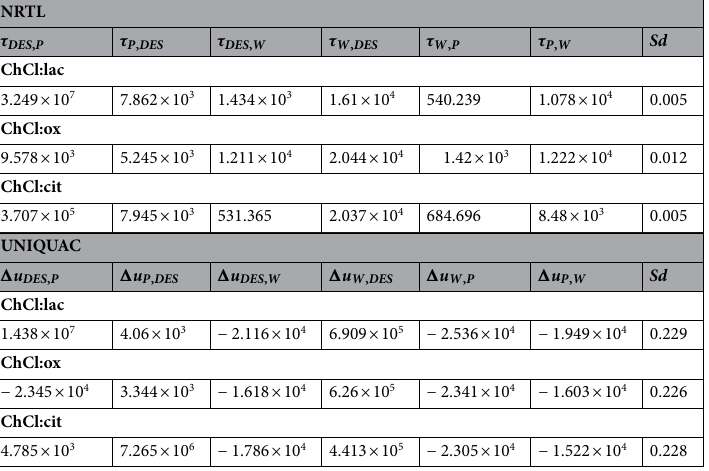
Table 4. Values of parameters of the NRTL and UNIQUAC models for {PPG400 + DES + H 2 O} systems at T = 298.15 K. a sd = number of binodal data,